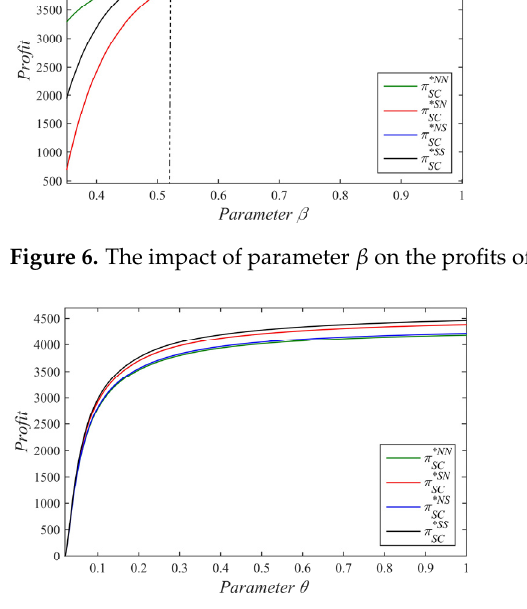
θ on the profits of supply chain. Figure 7. The impact of parameter